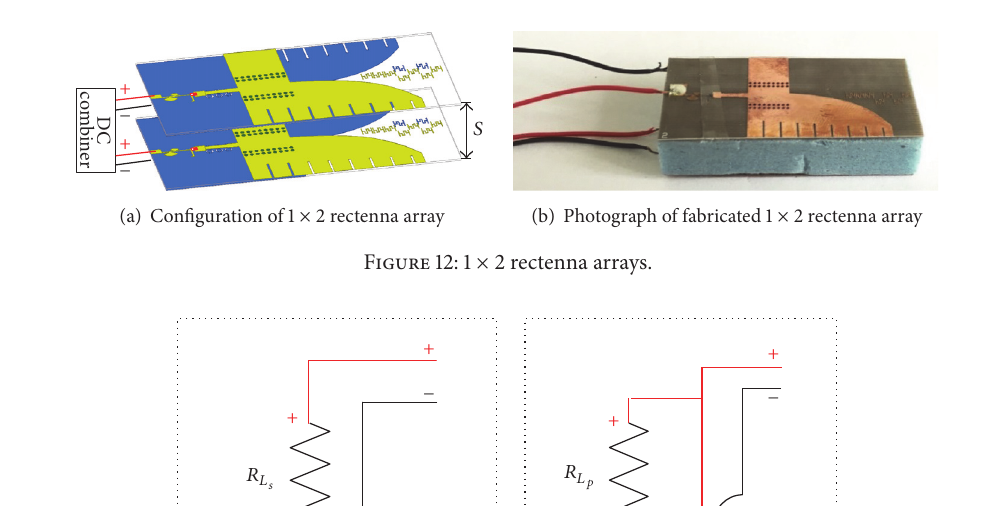
Figure 11: Photograph of the fabricated rectenna.